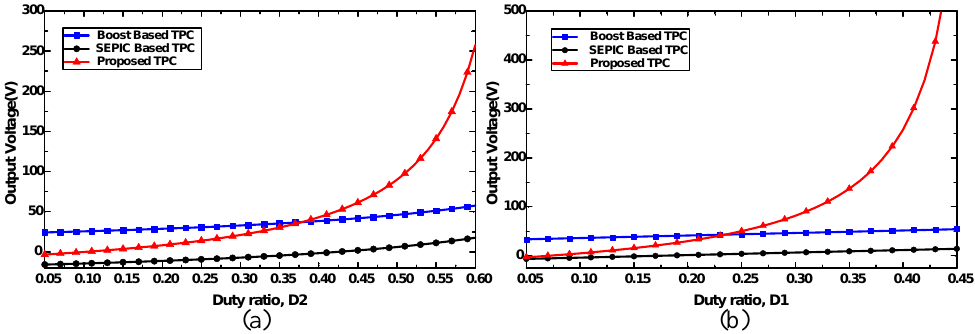
Figure 4. Comparison of static gains in the above-mentioned TPC. ( a ) Output voltage when d 1 = 0.51, and ( b ) output voltage when d 2 =